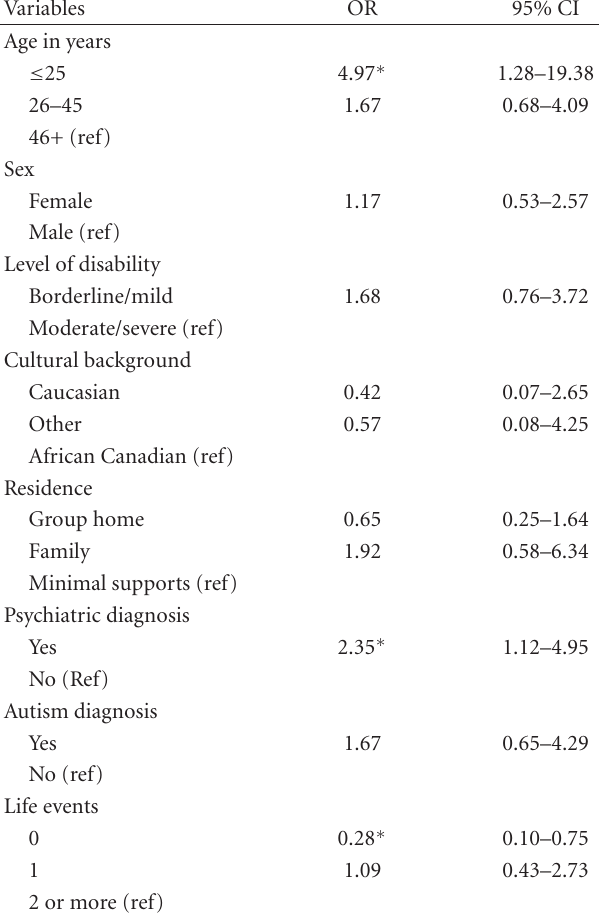
Table 3: Adjusted odds ratios of association between variables and type of emergency visits (psychobehavioral versus medical